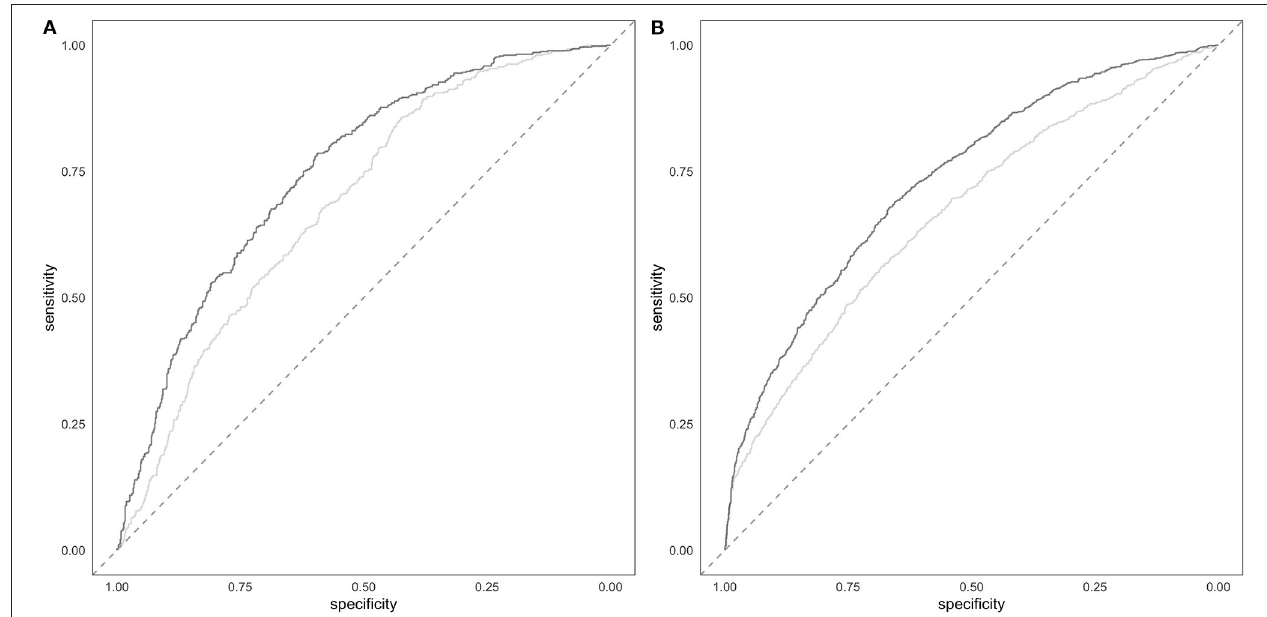
FIGURE 4 | Prediction of hypertension. Target (A) and validation (B) ROC of the full model including PRS and covariates (darker line) and of the covariates-only (i.e., BMI, sex and 4PC) model (lighter line).